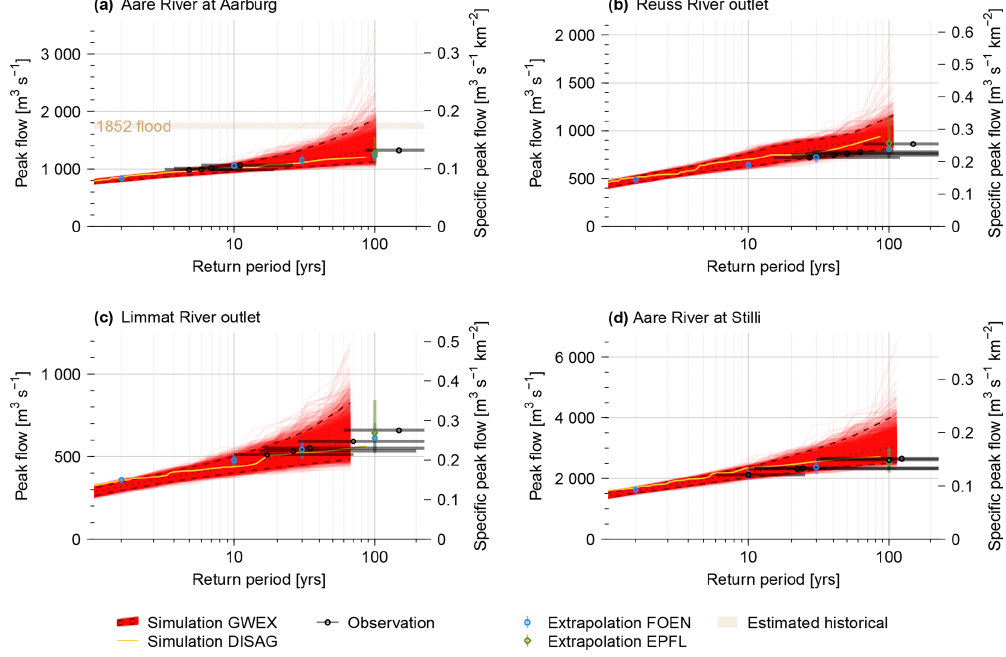
Figure 13. Exceedance curves for AMFs from 289000 years of CS based on GWEX weather generator scenarios (red), split up into blocks with length equal to that of observed peak flow records. Results are shown for the Aare River at Aarburg ( a , block length of 100 years), the outlets of rivers Reuss ( b , 106 years) and Limmat ( c , 65 years), and for the Aare River close to the outlet at Stilli ( d , 112 years). Orange: AMFs from 85 years of simulation (median representative parameter set) using disaggregated weather observations for 1930–2014 (DISAG); black: top-five observed peak flows drawn at return periods estimated by FOEN (Baumgartner et al., 2013); blue: extrapolation of observed peak flow records by FOEN (Baumgartner et al., 2013); green: regionally enhanced extrapolation of observed peak flow records according to EPFL (Asadi et al., 2018); light brown (for Aare at Aarburg only): range of reconstructed historical floods (Baer and Schwab, 2020). Measurement sites do not always match simulation sites exactly; the corresponding observations and extrapolations have been scaled where necessary, assuming constant discharge per unit